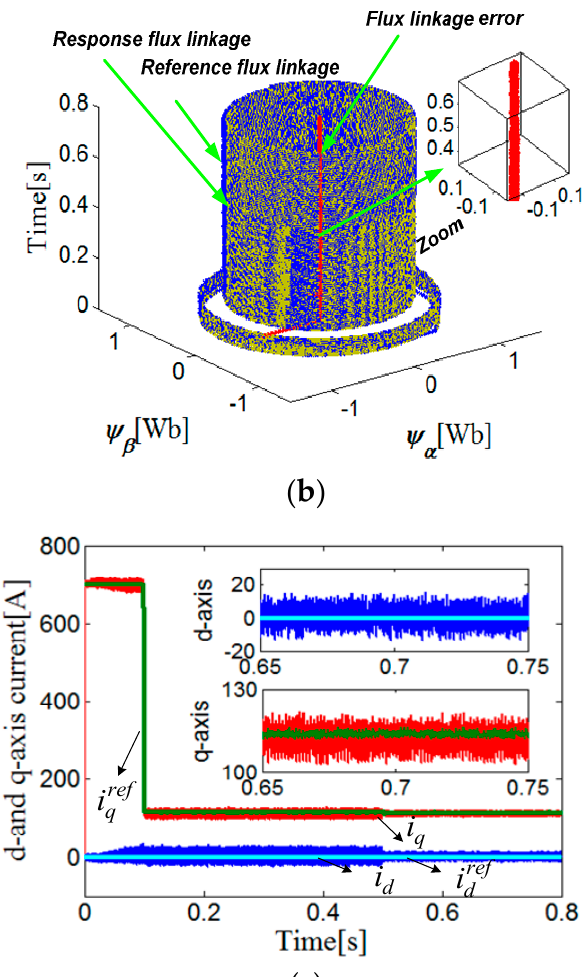
Figure 5. Simulation results of the RNPCC method under inductance parameter perturbation. ( a ) d ‐ and q -axis current responses and references; ( b ) three-dimensional rotor flux trajectories; ( c ) disturbance estimation results.